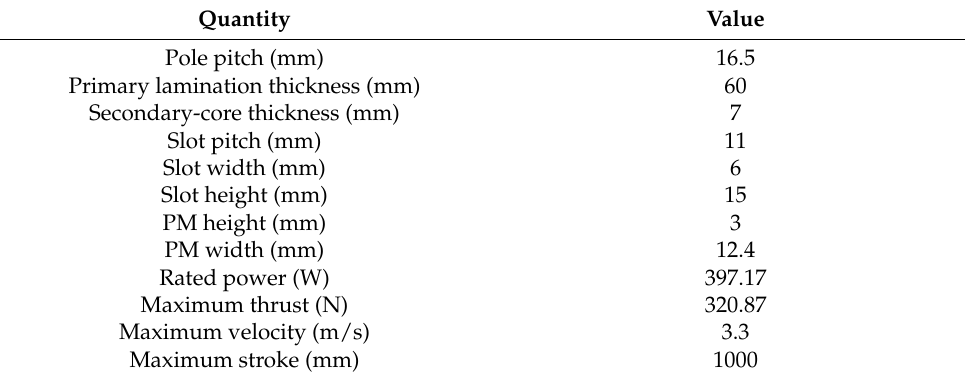
Table 1. Geometric parameters of 120 ◦ -TWDSPMLSM.